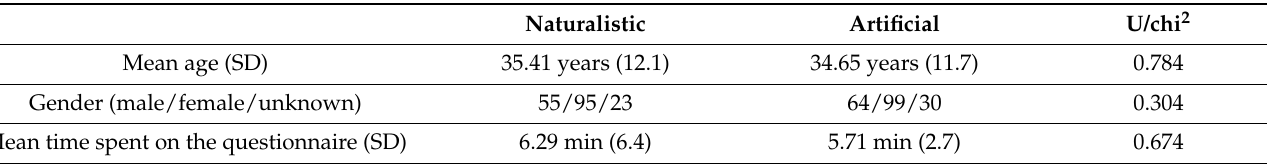
Table 2. Details of the participants involved in this study. The two groups did not significantly differ in terms of age, gender, or the time they spent filling out the